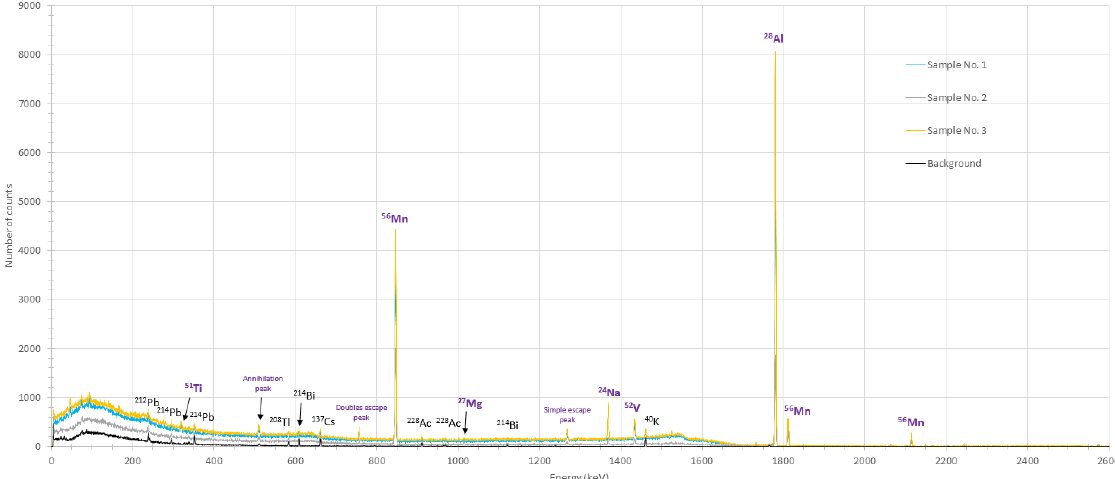
Fig. 9. Delayed gamma-ray spectra obtained for the three samples of soil with setup No. 1. Fig. 5. Delayed gamma-ray spectrum of the sample No. 1.